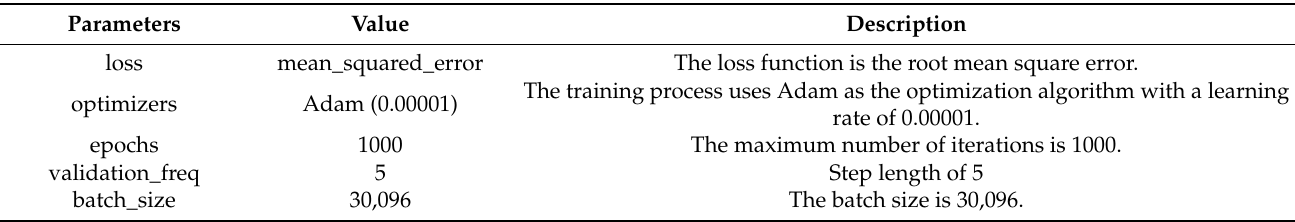
Table 3. LSTM parameter